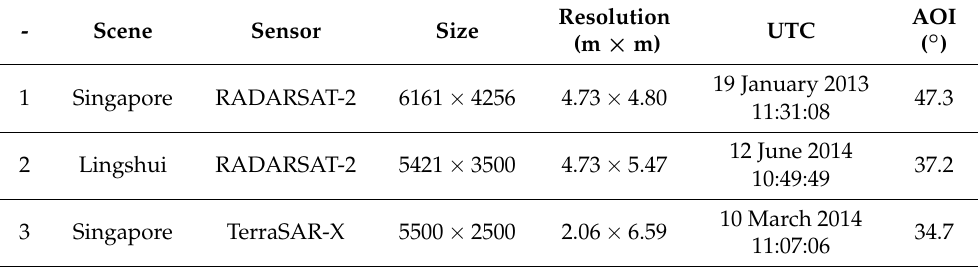
Table 1. Experimental dataset details; UTC stands for the international standard time; AOI stands for the angle of incident; m × m stands for meter times